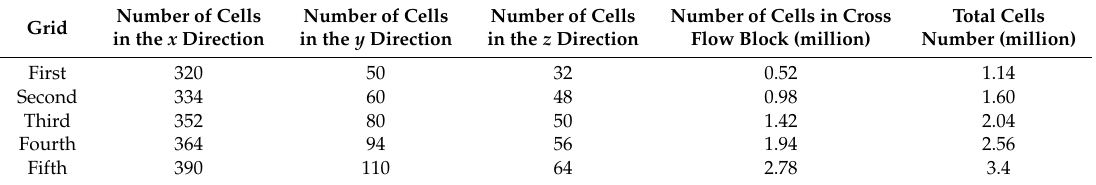
Figure 8. Grid sensitivity test of the LES calculation in the triple-hole system. Table 2. Specifications of mesh arrangements in the grid sensitivity test of the single-hole system. Table 3. Specifications of mesh arrangements in the grid sensitivity test of the triple-hole system.